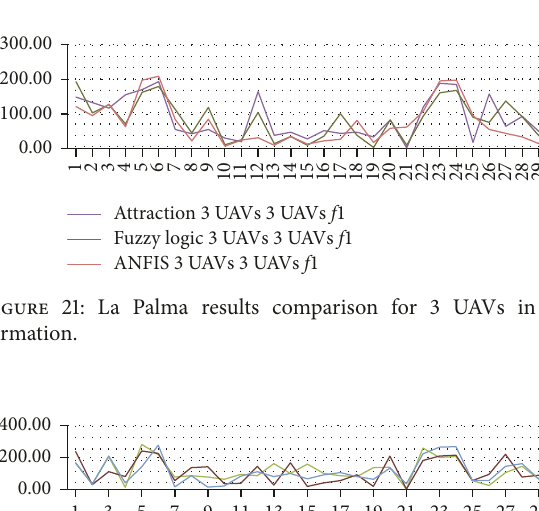
Figure 20: La Palma results comparison for 2 UAVs in free formation.